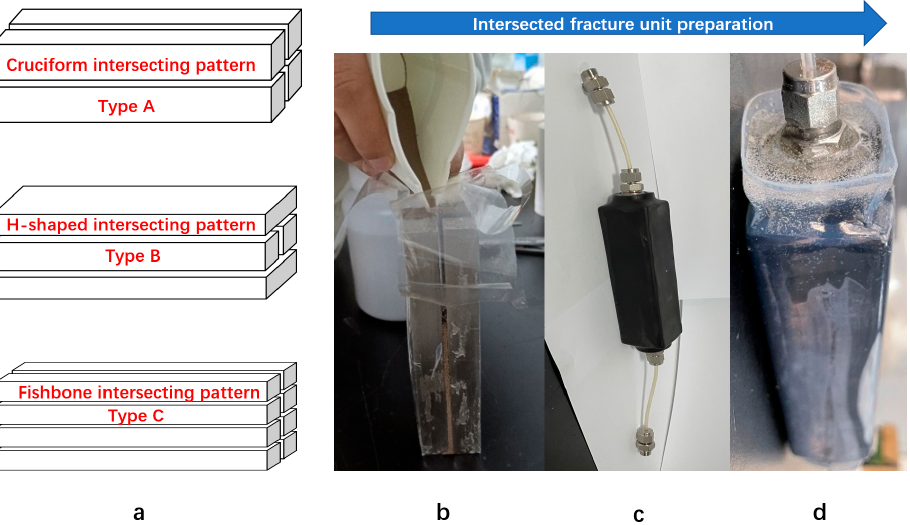
Figure 4. Intersected fracture patterns and intersected fracture units: ( a ) three intersected fracture patterns used in the experiments, ( b ) proppant placement into the intersected fracture unit, ( c ) intersected fracture unit sealed by a black heat-shrink sleeve, and ( d ) intersected fracture unit sealed by another transparent heat-shrink sleeve outside the black sleeve.